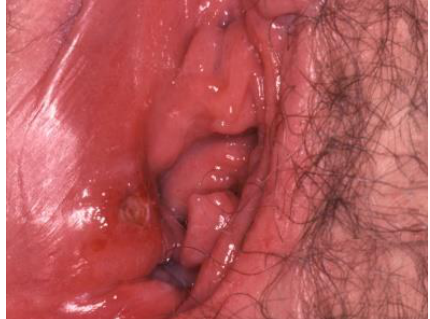
Figure 19. Ulcer in HIV-positive patient.